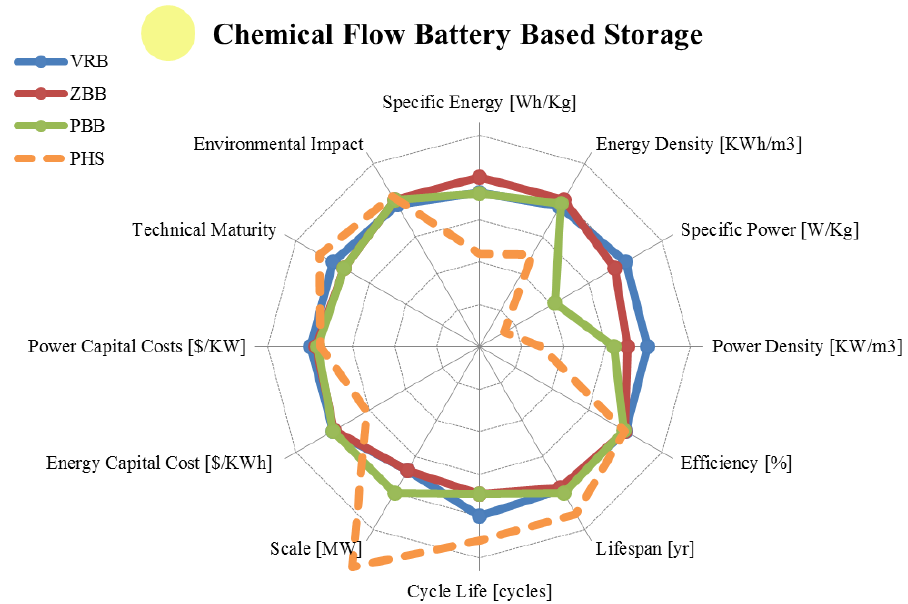
Figure 9. Comparing chemical storage and generation in flow batteries using normalized and logarithmically plotted data from Table 8